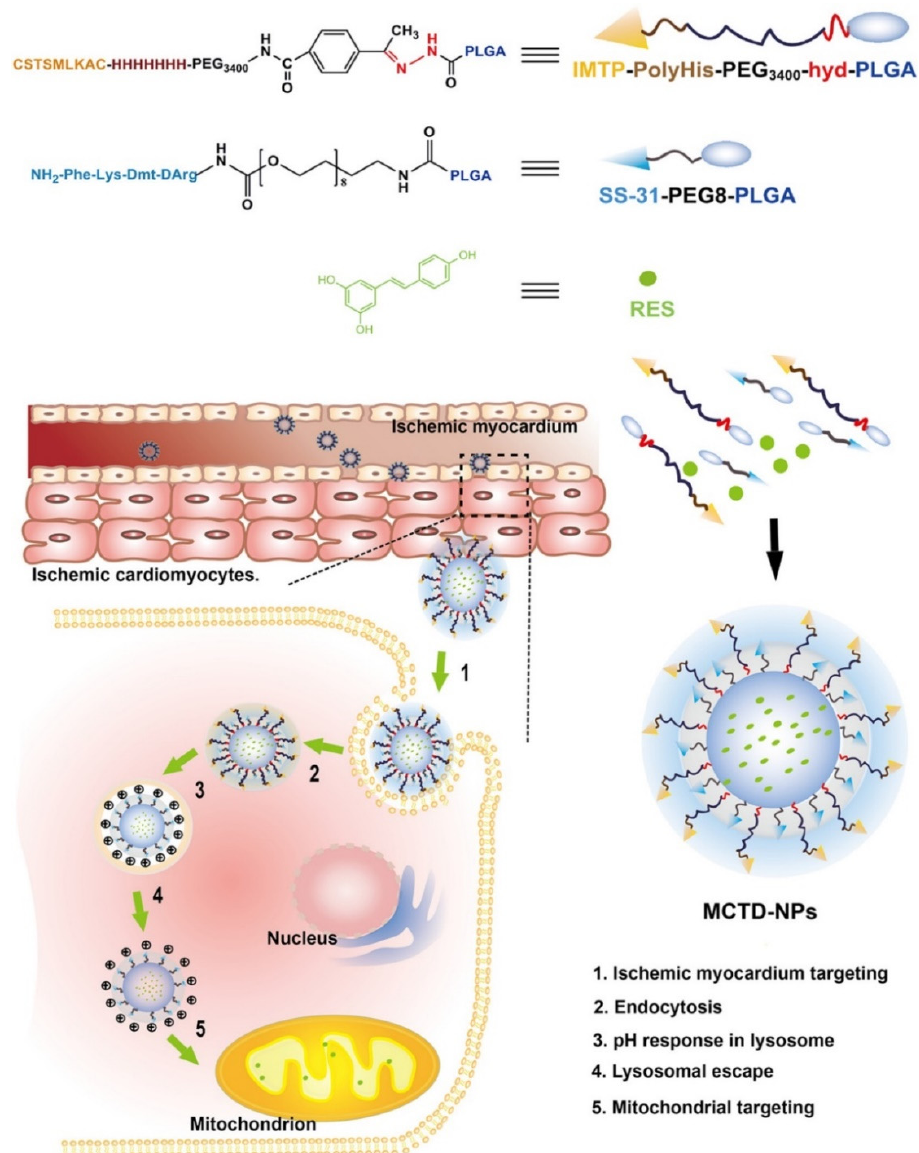
Figure 5. Schematic image of precise treatment of myocardial ischemia–reperfusion injury through multi-stage mitochondrial delivery of resvertrol by using MCTD-NPs